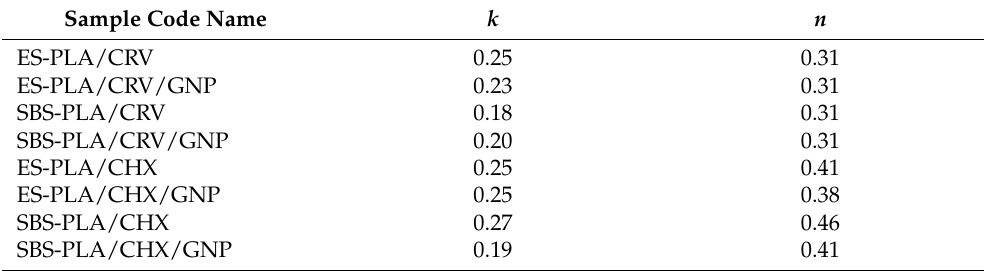
Table 2. Values of slopes ( n ) and intercepts ( k ) of fitting of Peppas–Korsmeyer model power law applied to the release data collected in the burst region (M t /M ∞ <